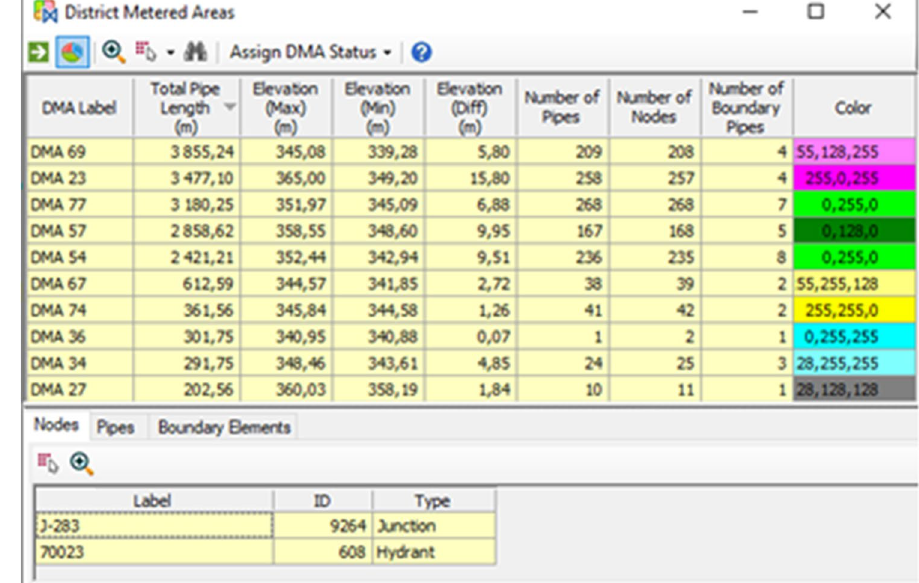
Fig. 5 DMA-Tool result